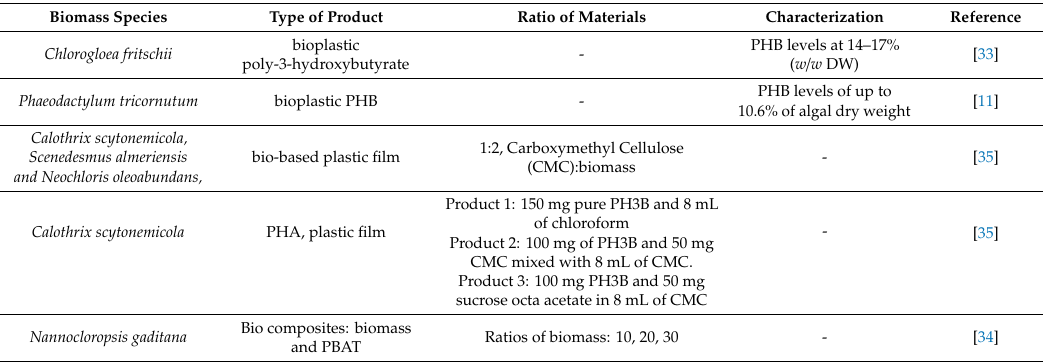
Table 4. Summary of conducted studies: other